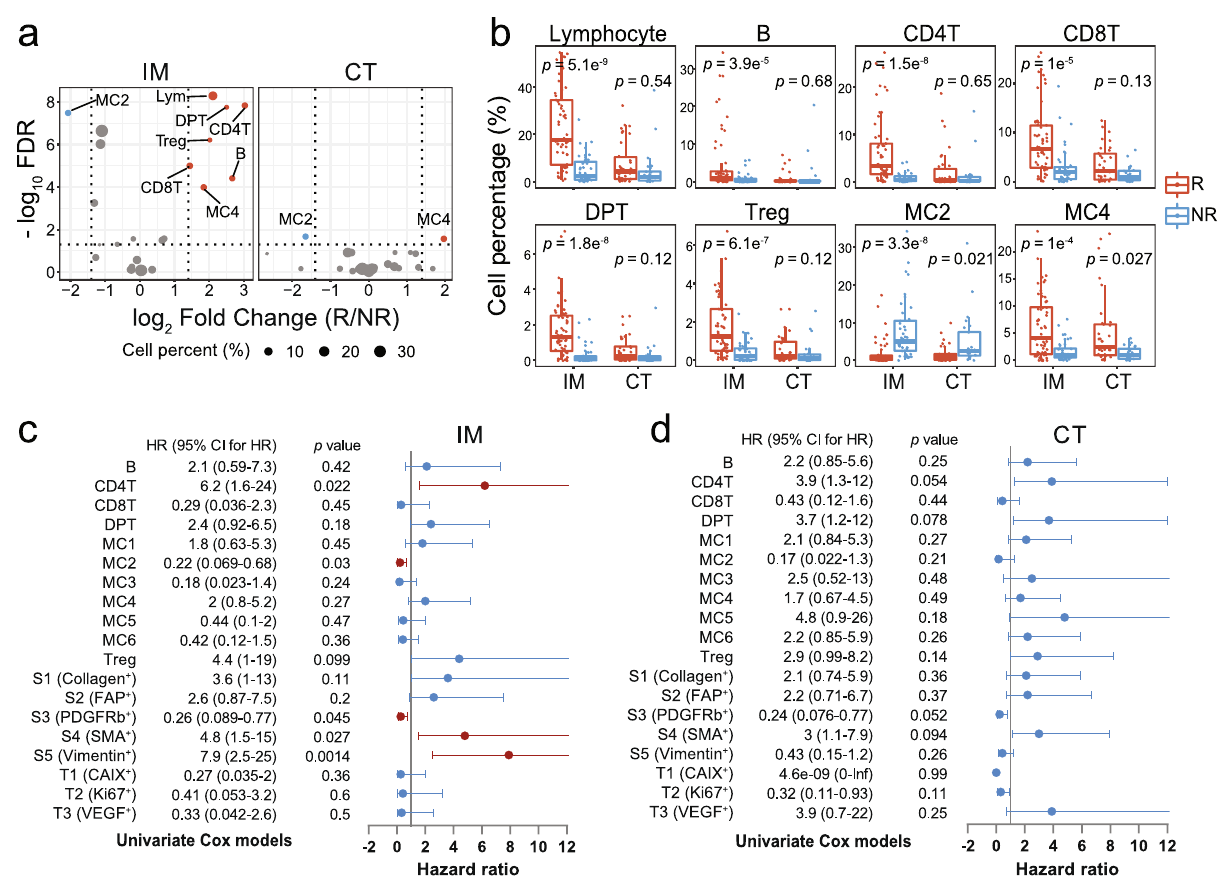
Fig. 2 The prognostic impact of cell phenotypes density. a Volcano plots showing differential testing of cell abundance in the invasive margin (IM, left) and core tumor (CT, right) between responders (R) and nonresponders (NR). The color of the nodes represents signi fi cantly higher abundance (red) and lower abundance (blue) of cell type in responders. The size of the nodes displays the percentage of cell type. b Boxplots showing the proportion of cell type in regions of interest from R (red) and NR (blue). Each boxplot is shown with the median (the center line), interquartile range (IQR), and 1.5 times the IQR (whiskers), with outliers exceeding 1.5 times the IQR. Points in the boxplot represent the cell percentage of each image. Comparisons were performed using Wilcoxon rank-sum test and adjusted with Benjamini – Hochberg method. a , b n = 58 for R group and n = 41 for NR group in the IM, n = 34 for R group and n = 25 for NR group in the CT. c , d Forest plots showing hazard ratios (nodes) and 95% con fi dence intervals (horizontal lines) of progression- free survival for each cell type in the IM ( n = 24 patients) ( c ) and CT ( n = 26 patients) ( d ) by univariate Cox models adjusted for age. The red nodes represent the signi fi cant factor with P value < 0.05. MC1: HLA-DR − CD14 + CD11c + myeloid cells, MC2: HLA-DR − CD14 + myeloid cells, MC3: HLA-DR − CD11b hi myeloid cells, MC4: HLA-DR hi CD14 hi CD16 + CD11c + CD11b + myeloid cells, MC5: HLA-DR + CD14 hi CD16 + CD11b + myeloid cells, MC6: HLA-DR + CD14 + myeloid